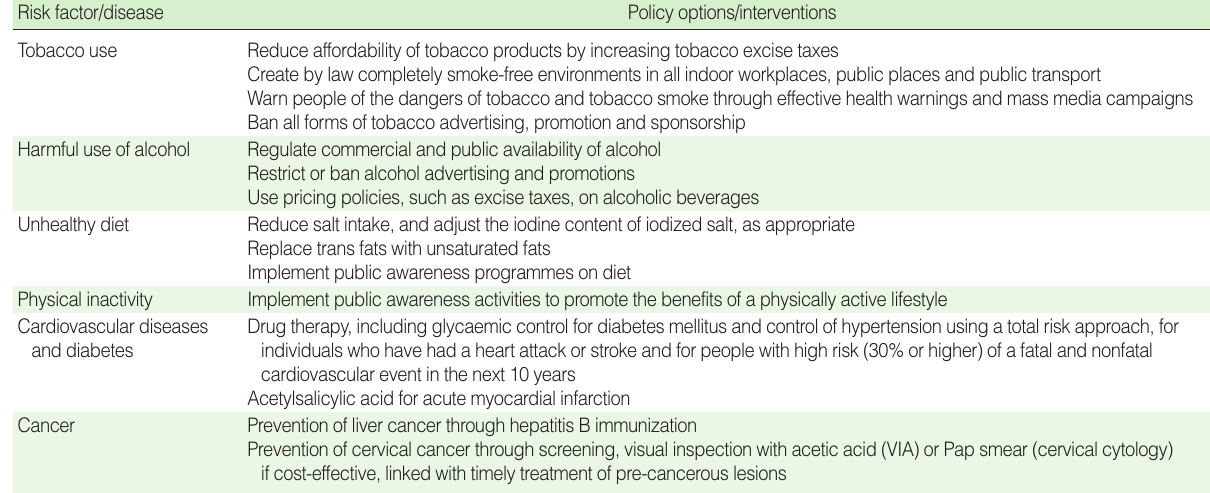
Risk factor/disease Policy